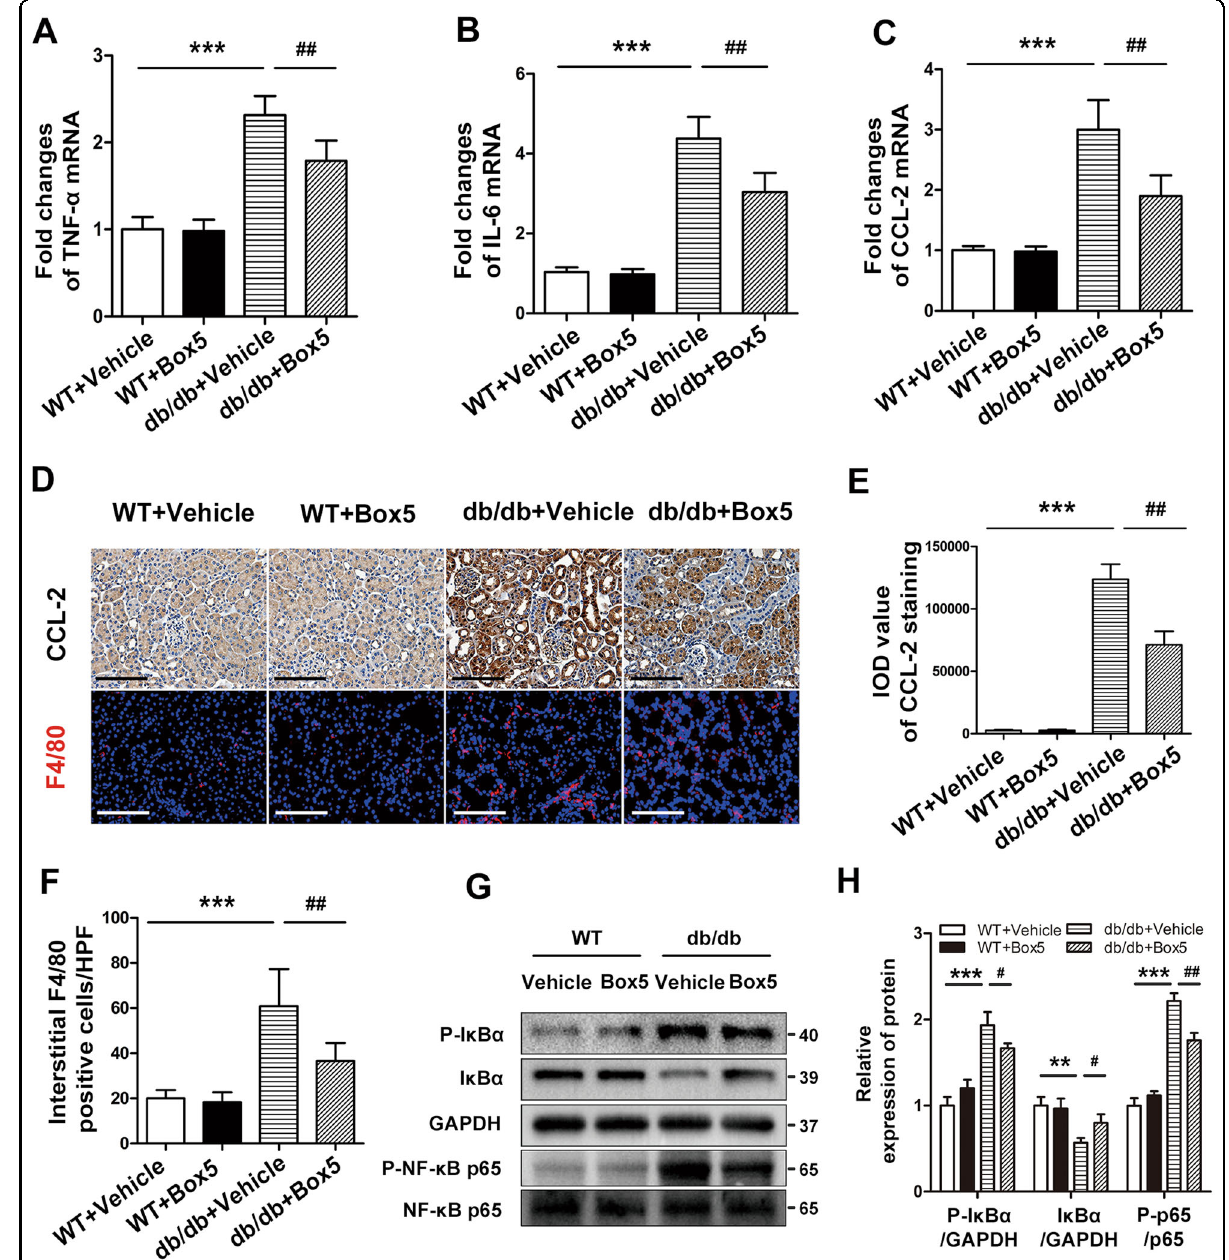
Fig. 4 Box5 treatment prevented diabetes-induced renal in fl ammation in db/db mice. A – C The mRNA levels of the proin fl ammatory cytokines tumor necrosis factor-a (TNF- α ), interleukin (IL)-6, and CCL-2/MCP-1 were determined by real-time PCR in all groups. *** P < 0.001, versus WT + Vehicle mice, ## P < 0.01, versus db/db + Vehicle mice. D Immunohistochemical staining of proin fl ammatory cytokine CCL-2 in kidney tissue isolated from all groups. Renal macrophage in fi ltration in these groups was also evaluated by immuno fl uorescent detection of F4/80 (red dots). Original magni fi cation, ×400; scale bar, 50 μ m. E Quantitative analysis of CCL-2 staining in kidney sections according to each group by the average IOD. *** P < 0.001, versus WT + Vehicle mice, ## P < 0.01, versus db/db + Vehicle mice. F The numbers of F4/80 + cells per high-power fi eld (HPF) were counted in the tubulointerstitium. *** P < 0.001, versus WT + Vehicle mice, ## P < 0.01, versus db/db + Vehicle mice. G Representative western blot analysis of phosphorylated I κ B, I κ B, phosphorylated NF- κ B p65 and NF-kB p65 in renal tissue. H Quanti fi cation of western blots by densitometric analysis. *** P < 0.001, ** P < 0.01 versus WT + Vehicle mice, ## P < 0.01, # P < 0.05, versus db/db + Vehicle mice. PCR experiments were performed in triplicate. Western blotting and immunostaining were performed in duplicate. Representative pictures of eight mice were shown. All values were presented as mean ± SD. Two-sided unpaired t -tests and one-way ANOVA followed by Bonferroni multiple comparison test were